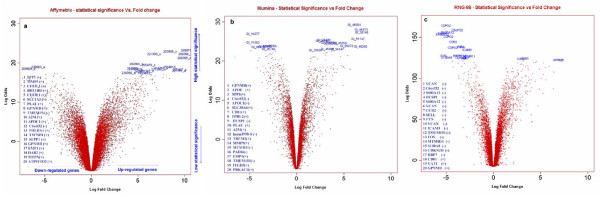
Volcano plots representing the relationship between fold change and statistical significance. On the x-axis are represented the log 2 fold change between the two groups (macrophages and monocytes). The vertical axis represents the log-Odds (B-Statistic) computed in Limma. Each gene is represented by a point and an up- and down-regulated gene appears symmetric. B statistics represents the log-odds that the gene is differentially expressed between the two groups. A low B-value indicates little evidence of differential expression. Highlighted genes represent the top 20 significant genes identified on Affymetrix (a), Illumina (b) and RNG-86 (c) platforms.